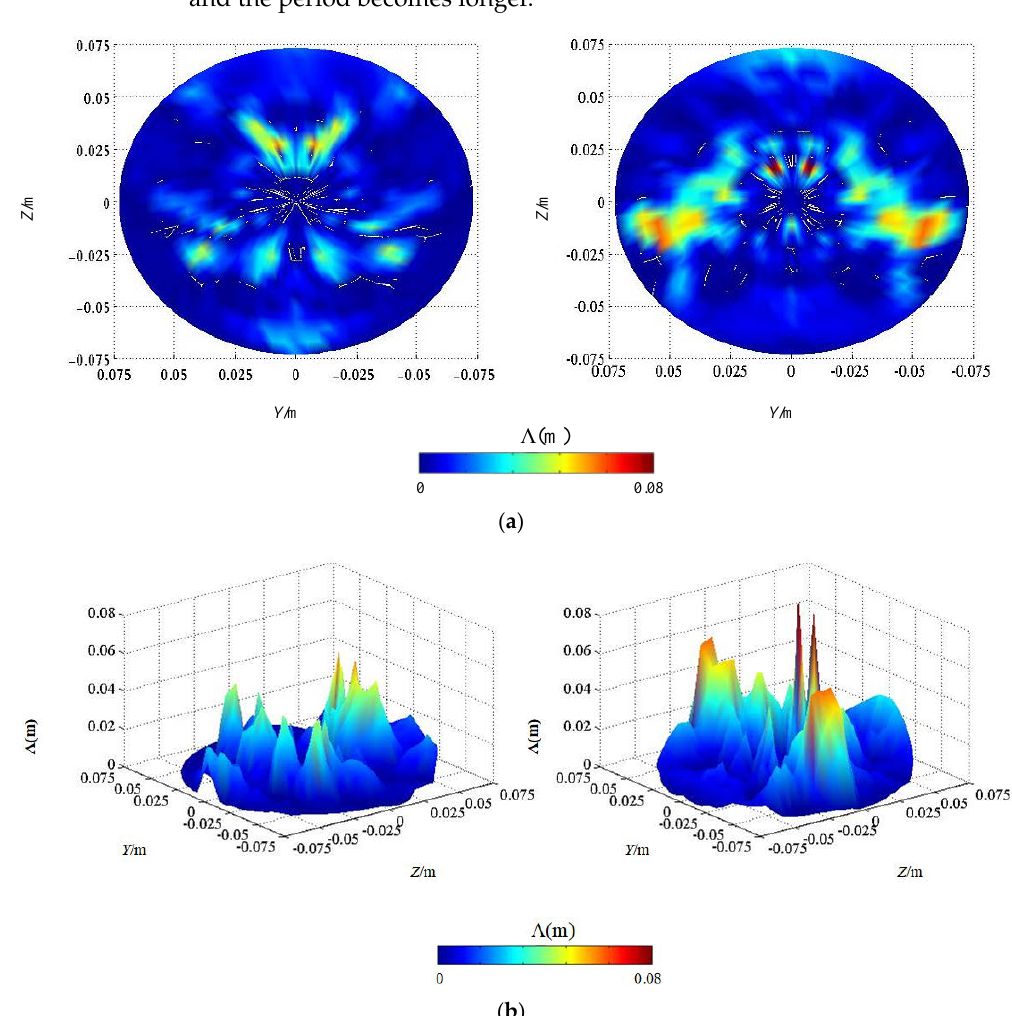
Figure 16. Comparison of turbulence integral scales of the wake field. ( a ) Two-dimensional turbulence integral scale of the wake field at 0 °C (left) and 25 °C (right). ( b ) Three-dimensional turbulence integral scale of the wake field at 0 °C (left) and 25 °C (right).